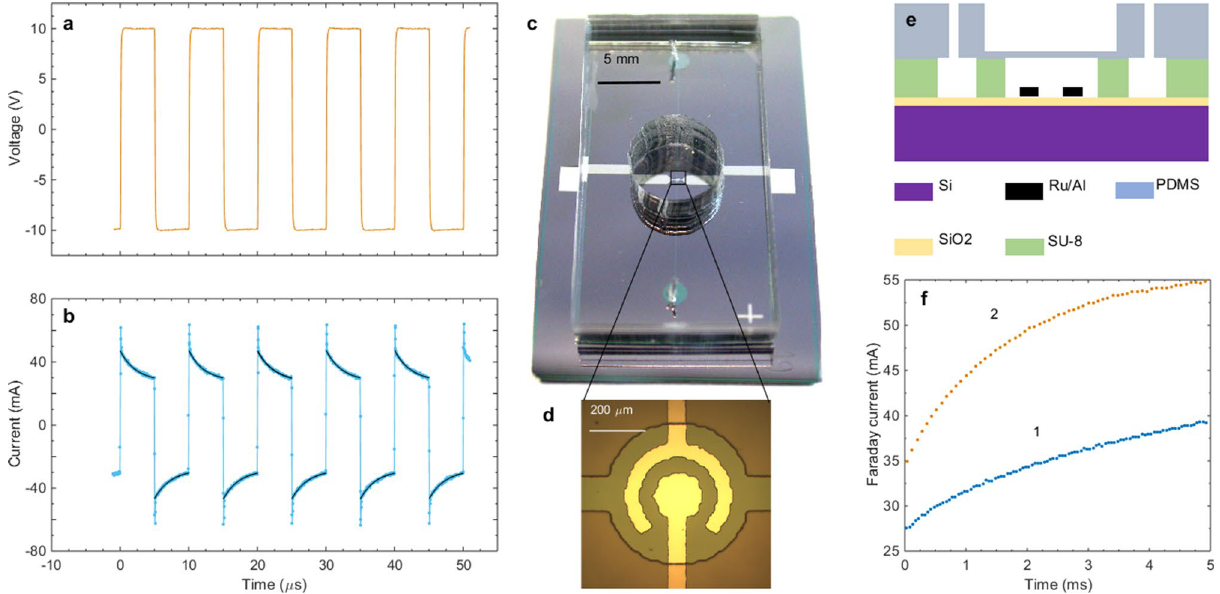
Figure 1. Actuator and driving pulses. ( a ) Alternating polarity voltage applied to the electrodes. ( b ) Current flowing through the electrochemical cell. For each pulse the current is described by the Faraday and charge- discharge components; the corresponding fits are shown by the black curves. ( c ) Optical image of the device; the actuator is located inside of the black rectangular. ( d ) Chamber of the actuator with the concentric electrodes. ( e ) Schematic view of the device (cross-section) showing the chamber with the electrodes covered by the PDMS membrane and openings to fill the chamber with the electrolyte. ( f ) Faraday current as a function of time for the driving frequency 100 kHz (1) and 500 kHz